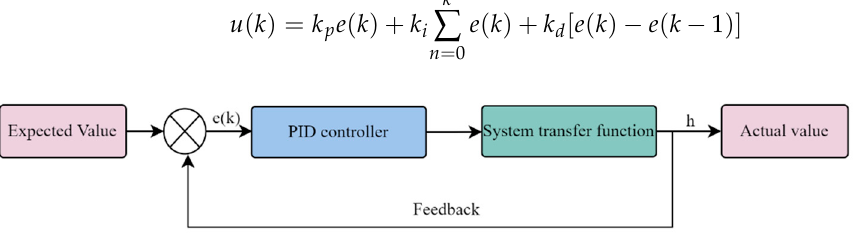
Figure 12. Structure of PID control system.